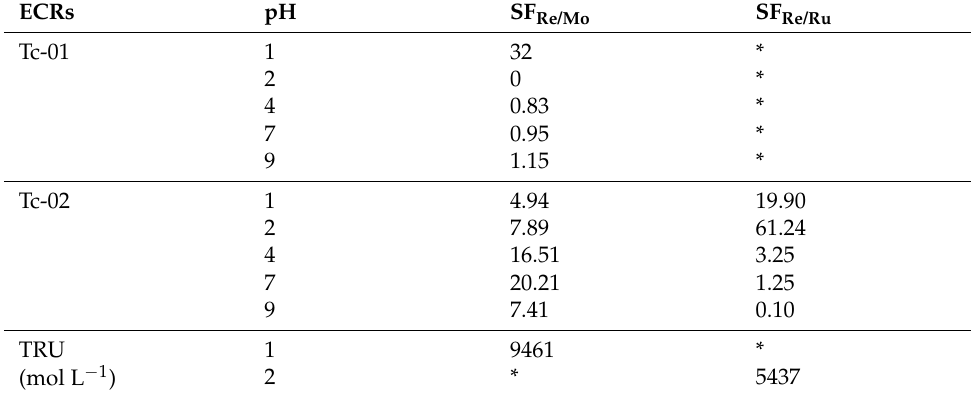
Table 1. Separation factor (SF) of Re vis- à -vis competing ions (Mo or Ru). ECRs pH SF Re/Mo SF Re/Ru Tc-01 1